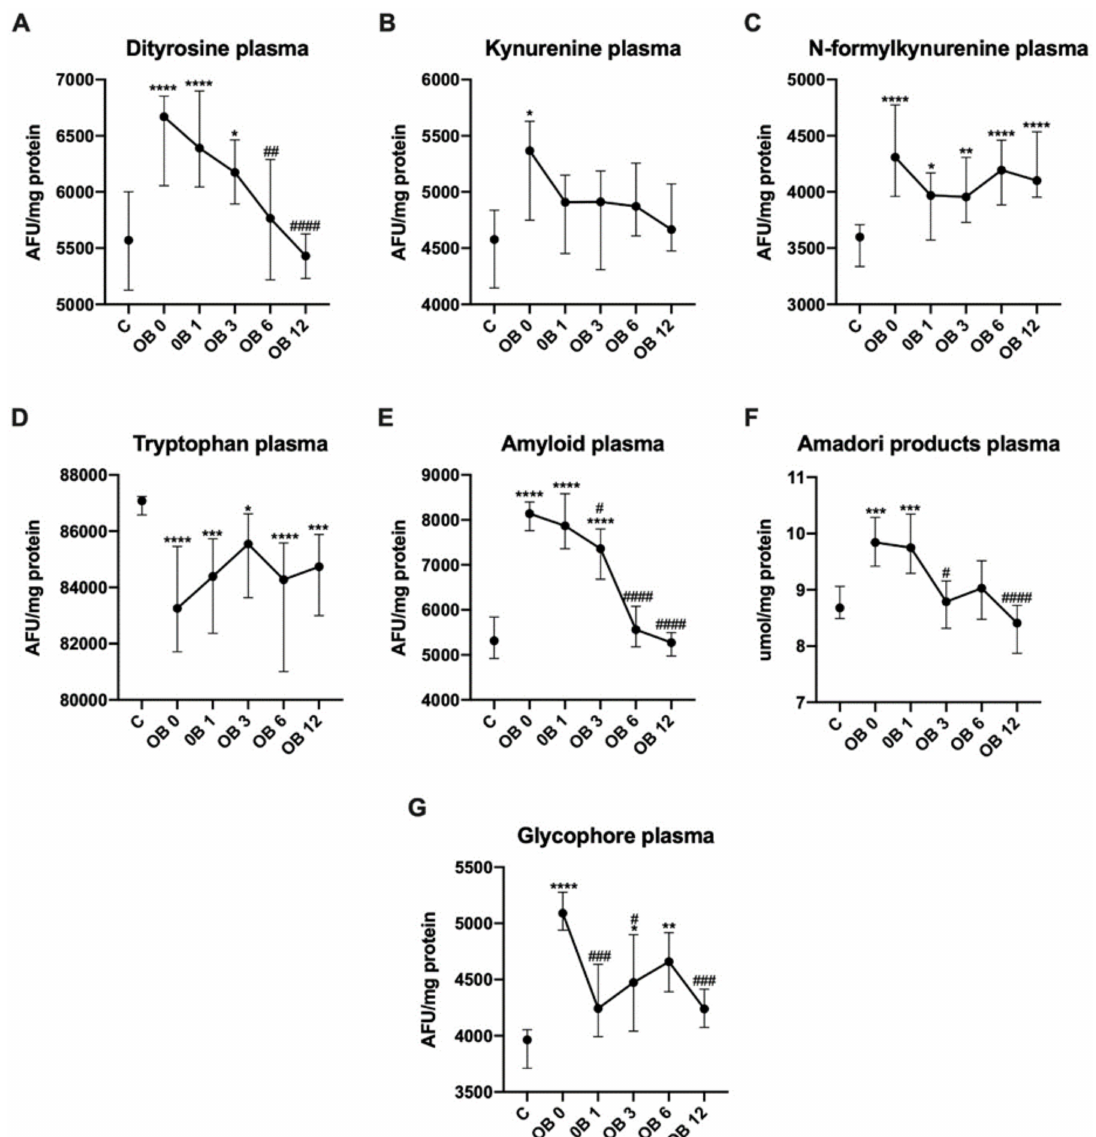
Figure 2. Plasma content of dityrosine ( A ), kynurenine ( B ), N-formyl-kynurenine ( C ), tryptophan ( D ), amyloid ( E ) and glycophore ( G ), as well as plasma concentration of Amadori products ( F ) of control (C) and morbid obesity (OB); data given as median and 95% Cl; * p < 0.05, ** p < 0.01, *** p < 0.001, **** p < 0.0001 indicate significant di ff erences from the control (C); # p < 0.05, ## p < 0.01, ### p < 0.001, #### p < 0.0001 indicate significant di ff erences from morbid obesity before laparoscopic sleeve gastrectomy (OB 0); morbidly obese patients before (OB 0), as well as 1 month (OB 1), 3 months (OB 3), 6 months (OB 6) and 12 months (OB 12) after sleeve gastrectomy. We observed increased kynurenine plasma content in OB ( + 17%, p = 0.0206) before laparoscopic sleeve gastrectomy in comparison with the controls (Figure